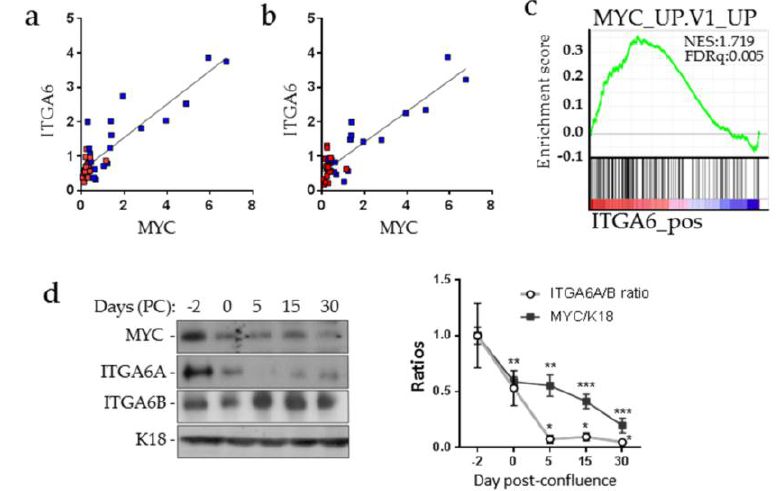
Figure 1. Integrin α 6A (ITGA6A) and MYC expression correlation in colorectal cancer cells. Correlation between ITGA6 ( a ) and ITGA6A ( b ) with MYC transcript expression was assessed in 20 primary colorectal cancer tumors (blue squares) and their resection margins (red squares). Pearson r = 0.8802; p ≤ 0.0001 ( ITGA6A vs. MYC ); Pearson r = 0.8933; p ≤ 0.0001 ( ITGA6 vs. MYC ).( c ) Positive correlation observed on a gene set enrichment analysis GSEA plot of enrichment of MYC upregulated genes in high ITGA6 expression specimens from the human colorectal cancer data set (GSE35896) using C2 MSigDB database.( d ) Representative Western blot analysis of ITGA6A, ITGA6B and MYC expression in Caco-2/15 cells in sub-confluent ( − 2 days), confluent (0 day) and post-confluent (5–30 days) monolayers and quantification of ITAG6A/ITGA6B and MYC/K18 ratios through the confluence. Cytokeratin 18 (K18) was used as a loading control. Statistically significantly different from -2 days post-confluence: * p ≤ 0.05; ** p ≤ 0.01; *** p ≤ 0.001. Pearson r = 0.9005 p ≤ 0.05 for ITGA6A/ITGA6B ratios vs. MYC/K18.